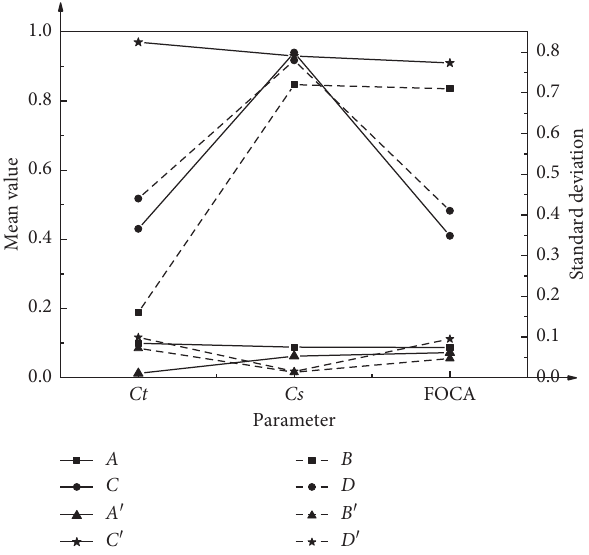
Figure 4: Mean and standard deviation simulation analysis results of FOCA